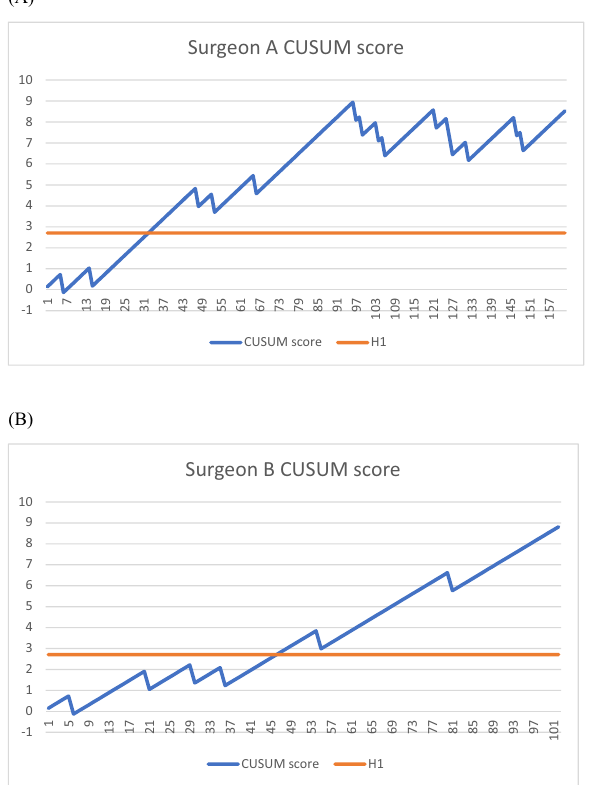
Figure 1. Cumulative sum control chart analysis of surgical failure. The learning curve of vaginal pelvic reconstruction surgeries. The x-axis indicates the number of procedures performed. The y-axis indicates the cumulative sum of success and failure of the surgical team in terms of surgical failure. Surgical failure is defined as recurrent prolapse beyond the hymen in 24 months postoperatively. The H1 line (orange) is designed to detect surgical proficiency. Proficiency is obtained when the graph crosses H1(2.709). Cumulative sum control chart analysis is based on an acceptable failure rate of 10% and an unacceptable failure rate of 20%. (A) Vaginal pelvic reconstruction without mesh performed by surgeon A. (B) Vaginal pelvic reconstruction with mesh performed by surgeon